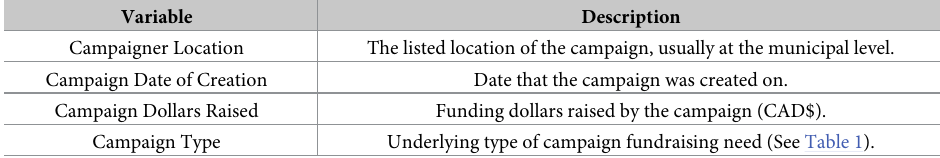
Table 3. Campaign study variables derived from scraped campaign